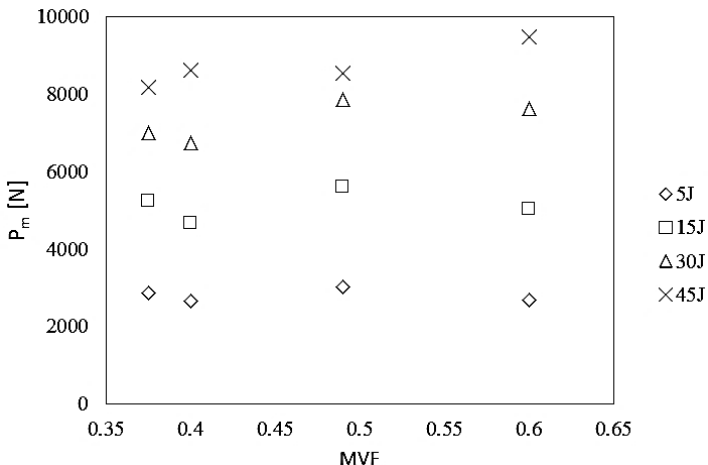
Figure 3. The relation between maximum force and metal volume fraction in HTCL under different impact energies.